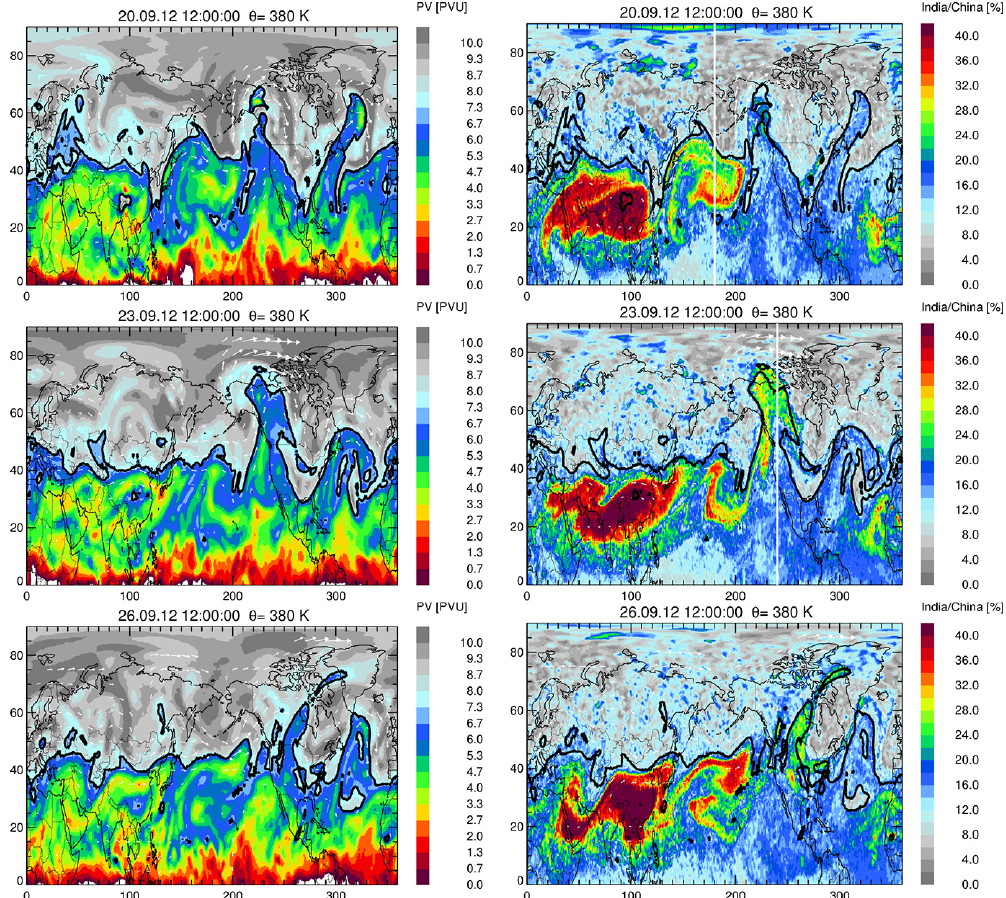
Figure 3. Horizontal distribution of PV (left) and the fraction of air originating in India/China (right) (here the sum of emissions from northern India, southern India, and eastern China) at 380K potential temperature on 20, 23, and 26 September 2012. The horizontal winds are indicated by white arrows. The 7.2PVU surface is shown as a thick black line, indicating the climatological isentropic transport barrier at 380K in September (Kunz et al., 2015). The thick white lines at 180 ◦ E and at 120 ◦ W mark the position of the vertical curtains shown in Figs. 5 and